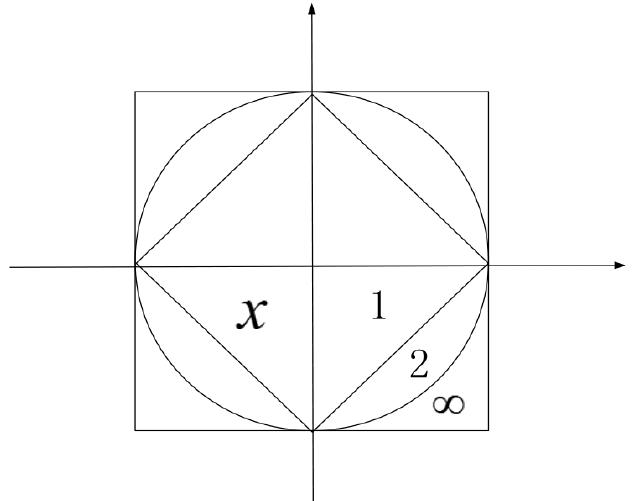
Figure 1. Two-dimensional spatial neighborhood